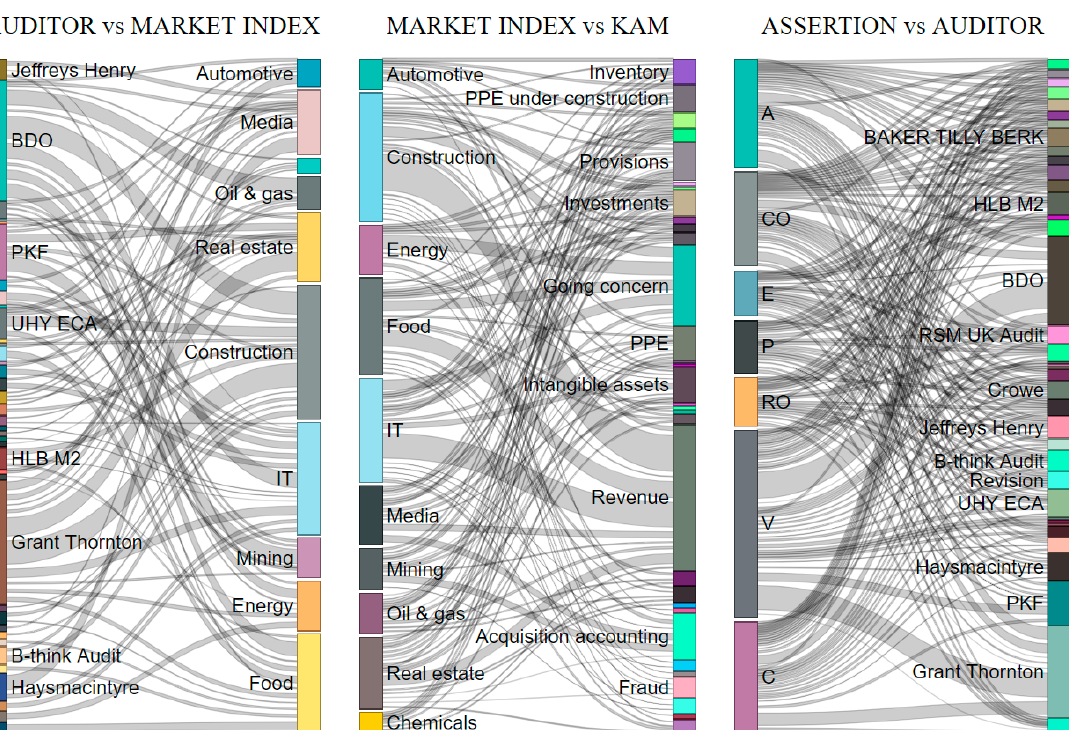
Figure 8. Relationships between auditors, KAMs, assertions, and WIGs—for non-Big 4 auditing firms. Source: own elaboration based on analyzed data.